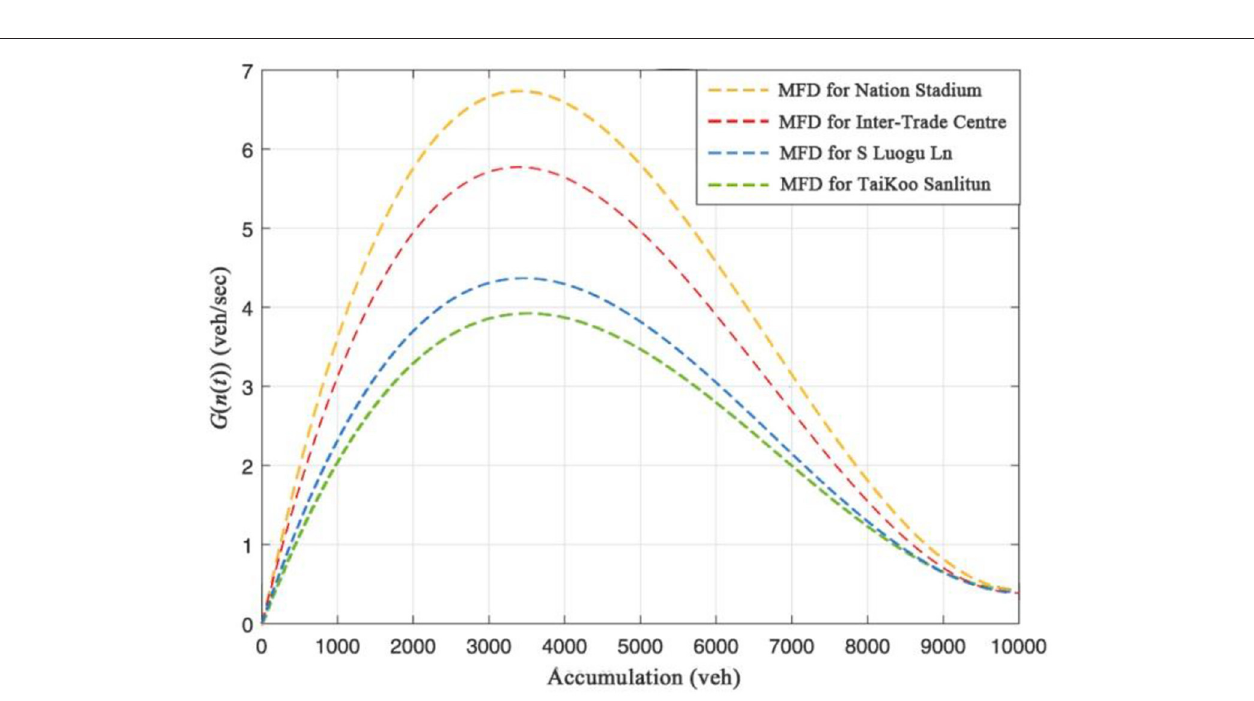
FIGURE 12 | The estimated MFDs for the four regions.